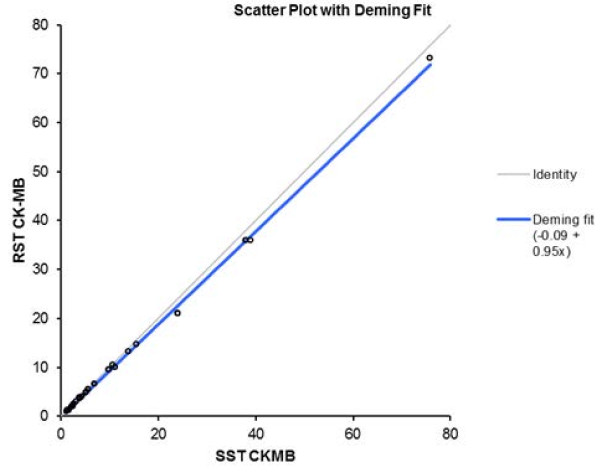
Deming fit (solid black line) with 95% confidence intervals for the SST CK-MB results vs RST results. Concentrations are expressed as nanograms per milliliter.